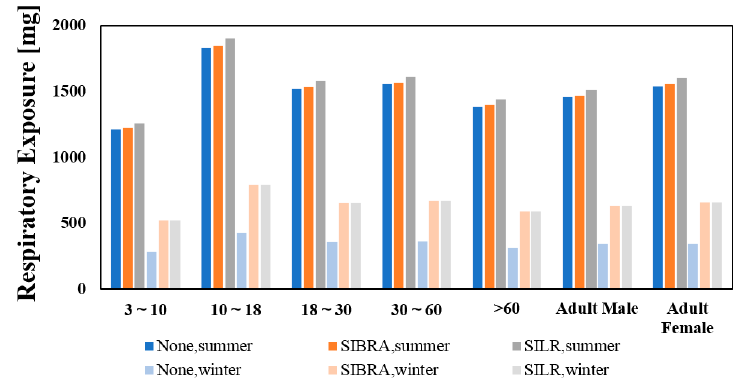
Figure 8. Respiratory exposure in different ages and genders.